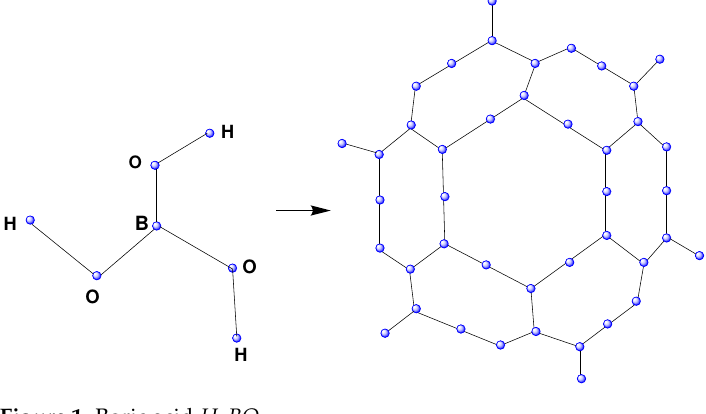
Figure 1. Boric acid H 3 BO 3